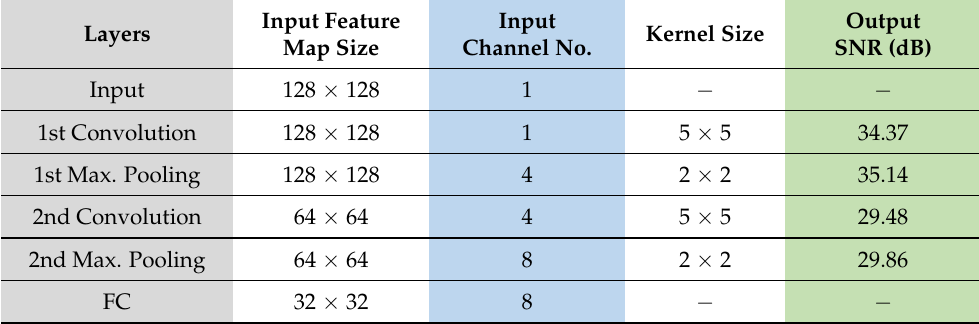
Table 9. Experimental CNN model architecture and SNR performances among layers.